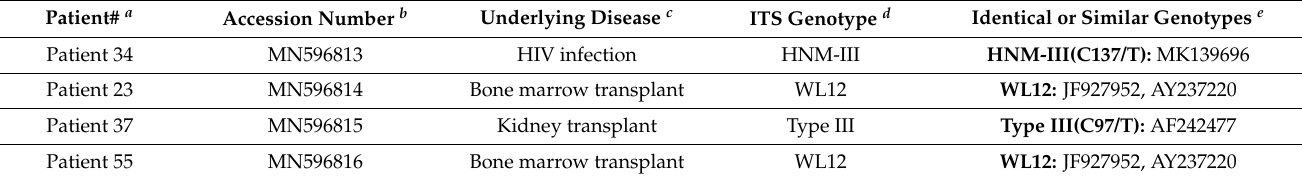
Table 2. Genotypic portrait of E. bieneusi infecting 14 microsporidia-positive immunocompromised